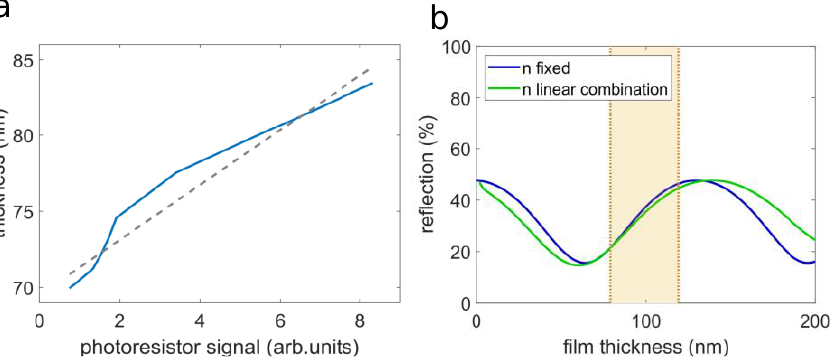
Figure 4. ( a ) Calibration curve for linking the photoresistor signal to the hydrogel’s thin film thickness. The solid line represents the experimental data and the dashed line represents a linear regression ( R 2 = 0.95). ( b ) The simulated intensity of the reflected beam versus the hydrogel’s film thickness. In blue: the refractive index of the hydrogel does not vary with the thickness (n fixed). In green: The thickness of the hydrogel is seen as a combination of hydrogel and water, and the refractive index is a linear combination of the refractive index of the dry hydrogel and water (n linear combination).